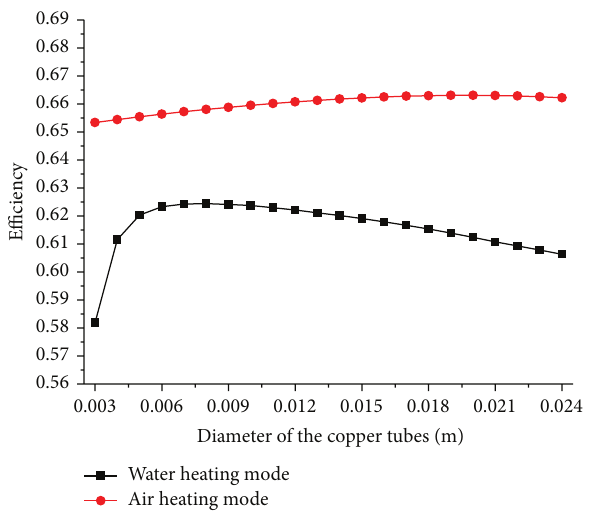
Figure 14: Effect of the diameter of copper tubes on efficiency of the collector in two working modes.